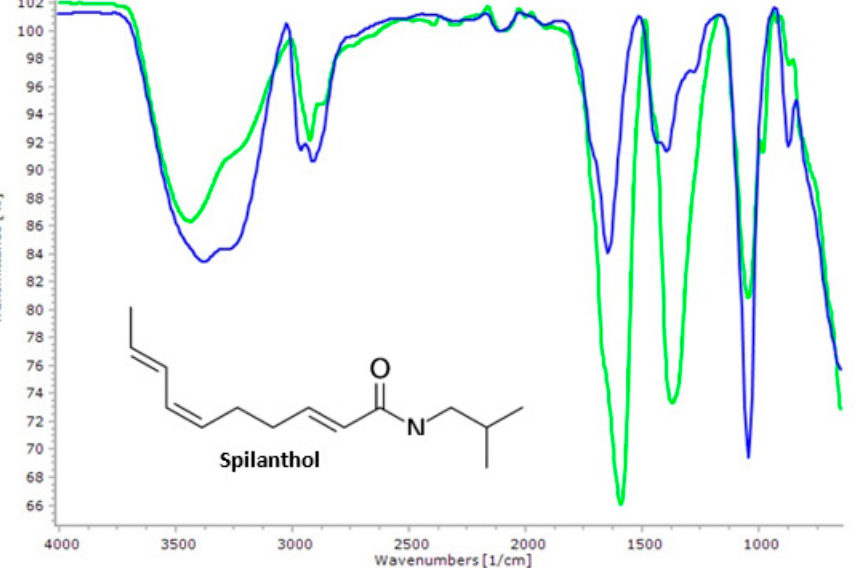
Figure 2. Infrared absorption spectrum in the region from 4000 cm − 1 to 600 cm − 1 of supercritical extraction—S E ( (cid:4) ) and standard spilanthol—S S ( (cid:4) extraction—S E ( ■ ) and standard spilanthol—S S ( ■ ).